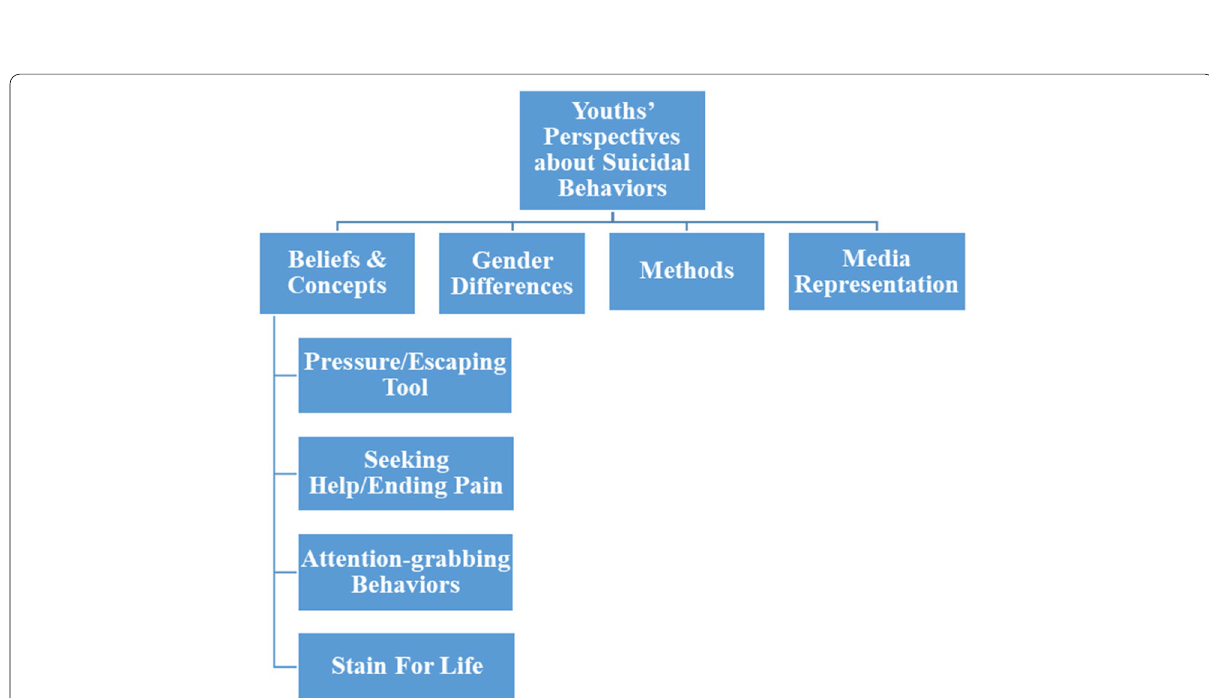
Fig. 3 Themes and subthemes that emerged as a result of the qualitative